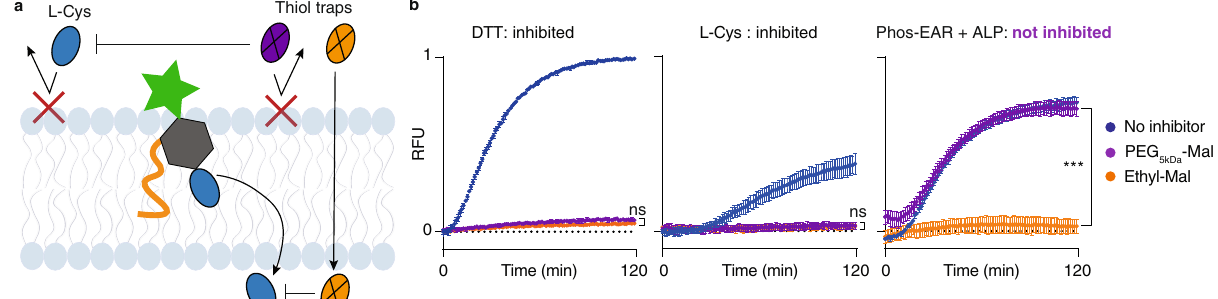
two maleimides it was 50 µ M. Results shown are based on three replicates with triplicates ( N =3, n =3), relative to the max of the DTT sample and shown as mean±SD. RFU=relative fl uorescence expressed in arbitrary units. Statistical sig- ni fi cancewasevaluated for the endpoint of the Ethyl-MalandPEG 5kDa -Malsamples within each individual plot via an unpaired two-tailed t test, *** P <0.001 (95% con fi dence interval), ns=non-signi fi cant. Source data are provided as the Source Data fi le.